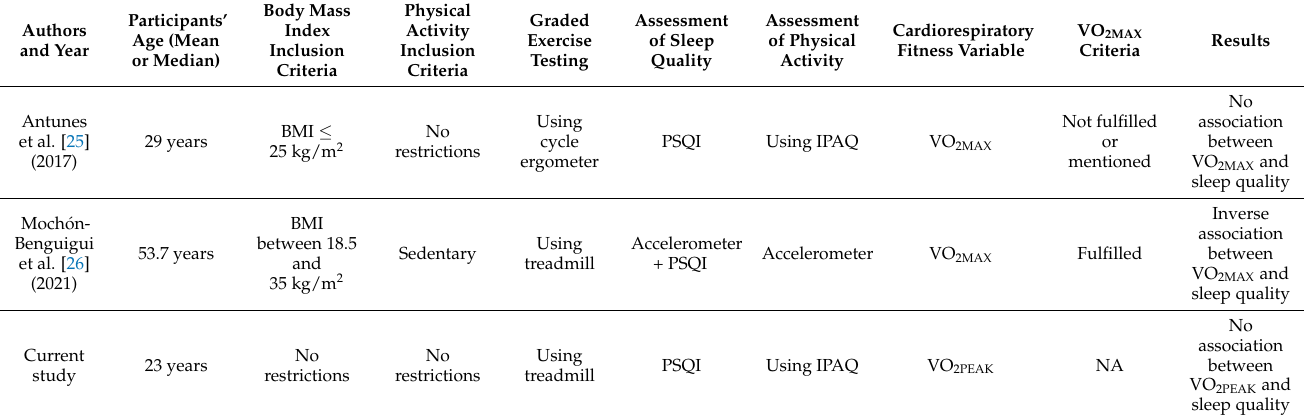
Table 6. A comparison between the current study and other studies using similar outcome